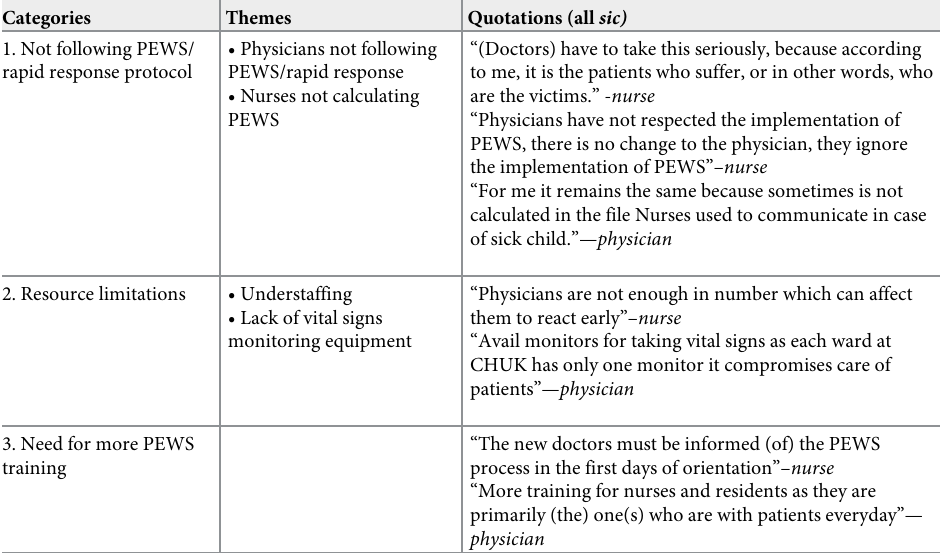
Table 4. Barriers to improvement following PEWS-RL/rapid response algorithm implementation—categories and themes expressed by 37 nurses and 24